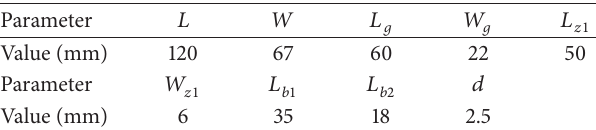
Table 1: Antenna dimensions.